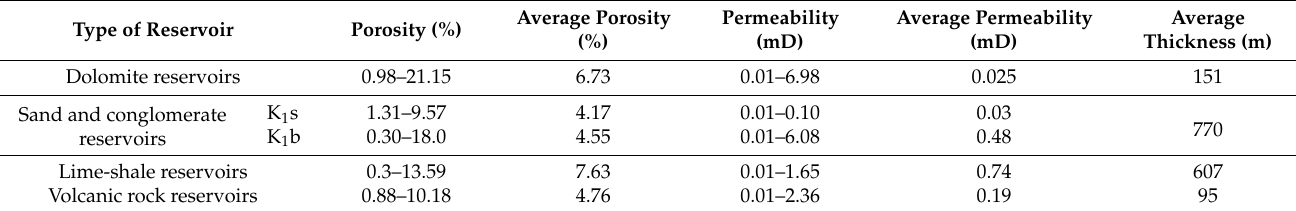
Figure 6. SEM pores in the conventional sand and conglomerate reservoirs. Table 5. Physical properties comparison for the Hari